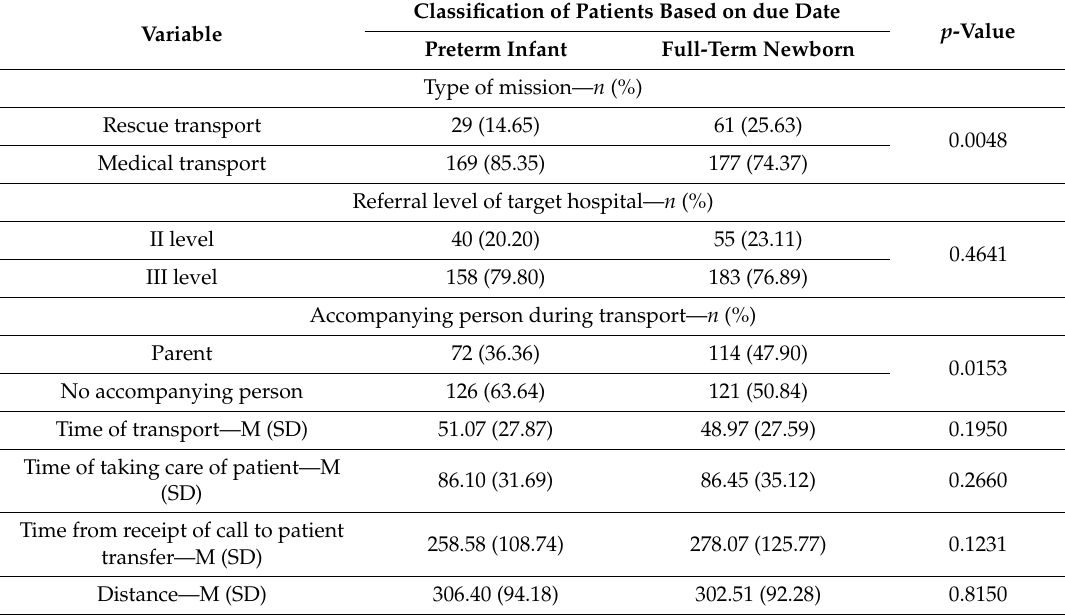
Table 3. Classification of patients based on the date of delivery vs. mission